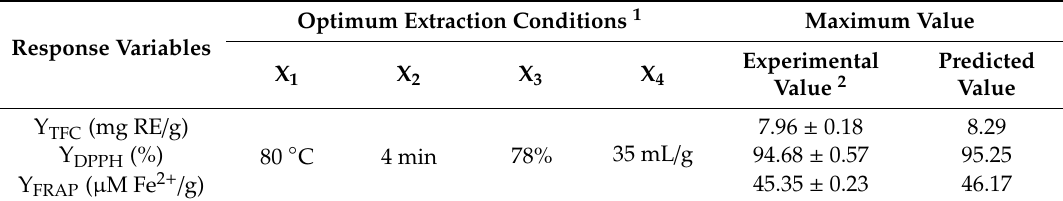
Table 3. Experimental values and predicted values of response variables at optimum extraction